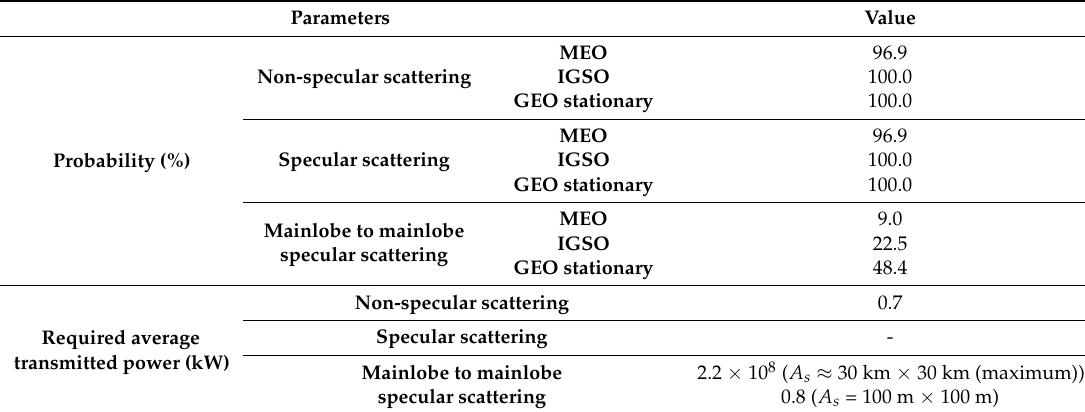
Table 7. Occurrence probability of the GNSS bistatic scattering RFI case and the average transmitted power requirement in GEO SAR (HH polarization, Shrub scene, in the specular scattering